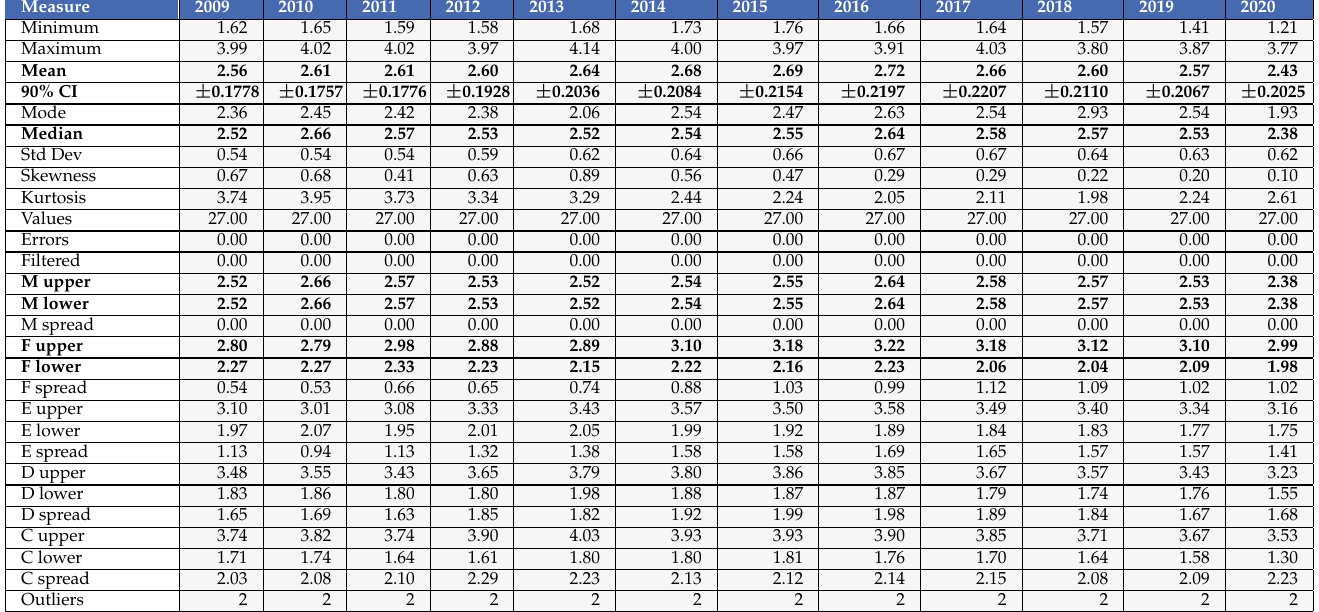
Table A2. Letter values—share of environmental tax revenues in the GDP of the EU27 in 2009–2020 (source: own study).